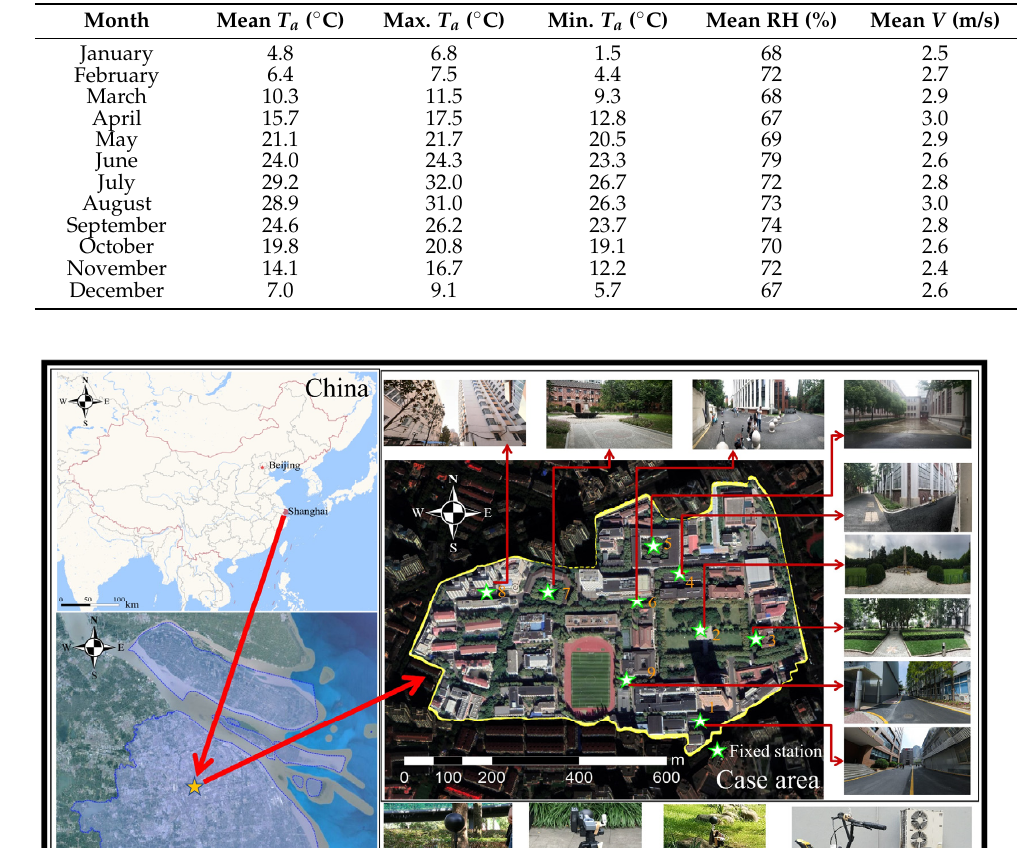
Table 1. Monthly T a , RH, and V in Shanghai from the year 2000 to 2010.